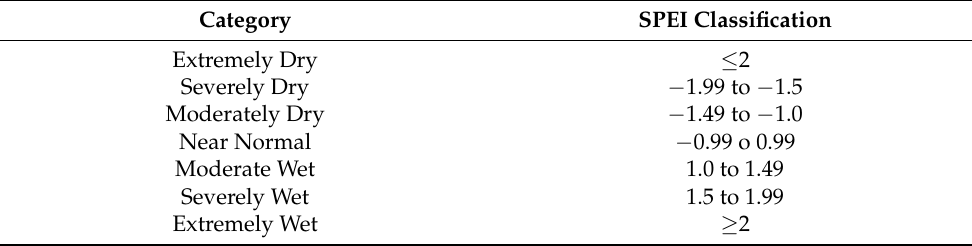
Table 2. SPEI drought classification for dry and wet grades